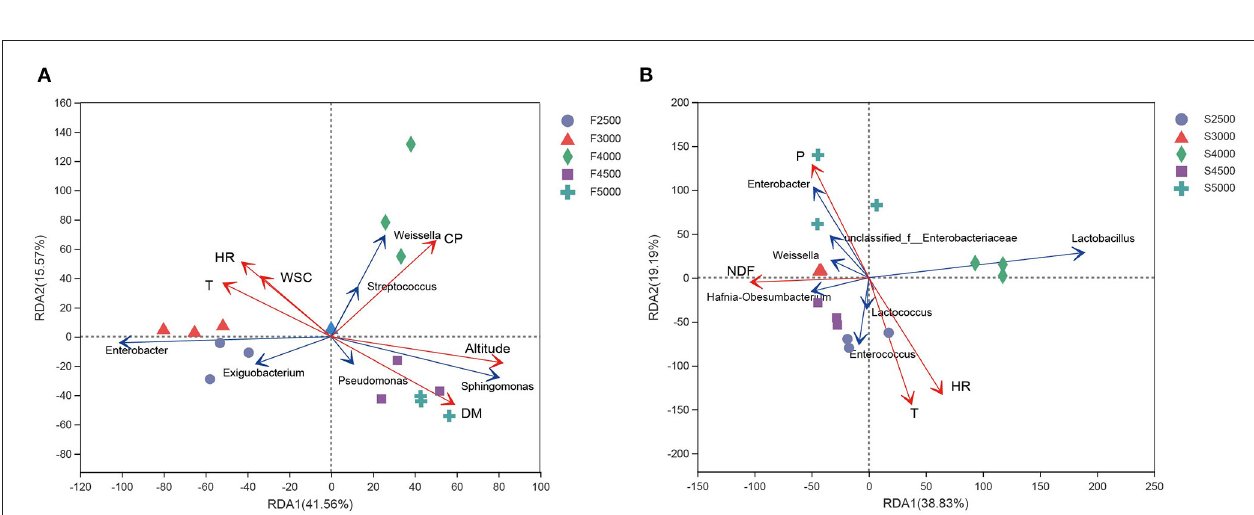
FIGURE 2 | The bacterial (A) and fungal (B) community on genus levels of fresh and ensiled K. pygmaea along the elevation gradient on the Tibetan Plateau. F2500, F3000, F4000, F4500, and F5000 represent samples of fresh K. pygmaea at corresponding altitude gradients. S2500, S3000, S4000, S4500, and S5000 represent samples of K. pygmaea silages at corresponding altitude gradients.